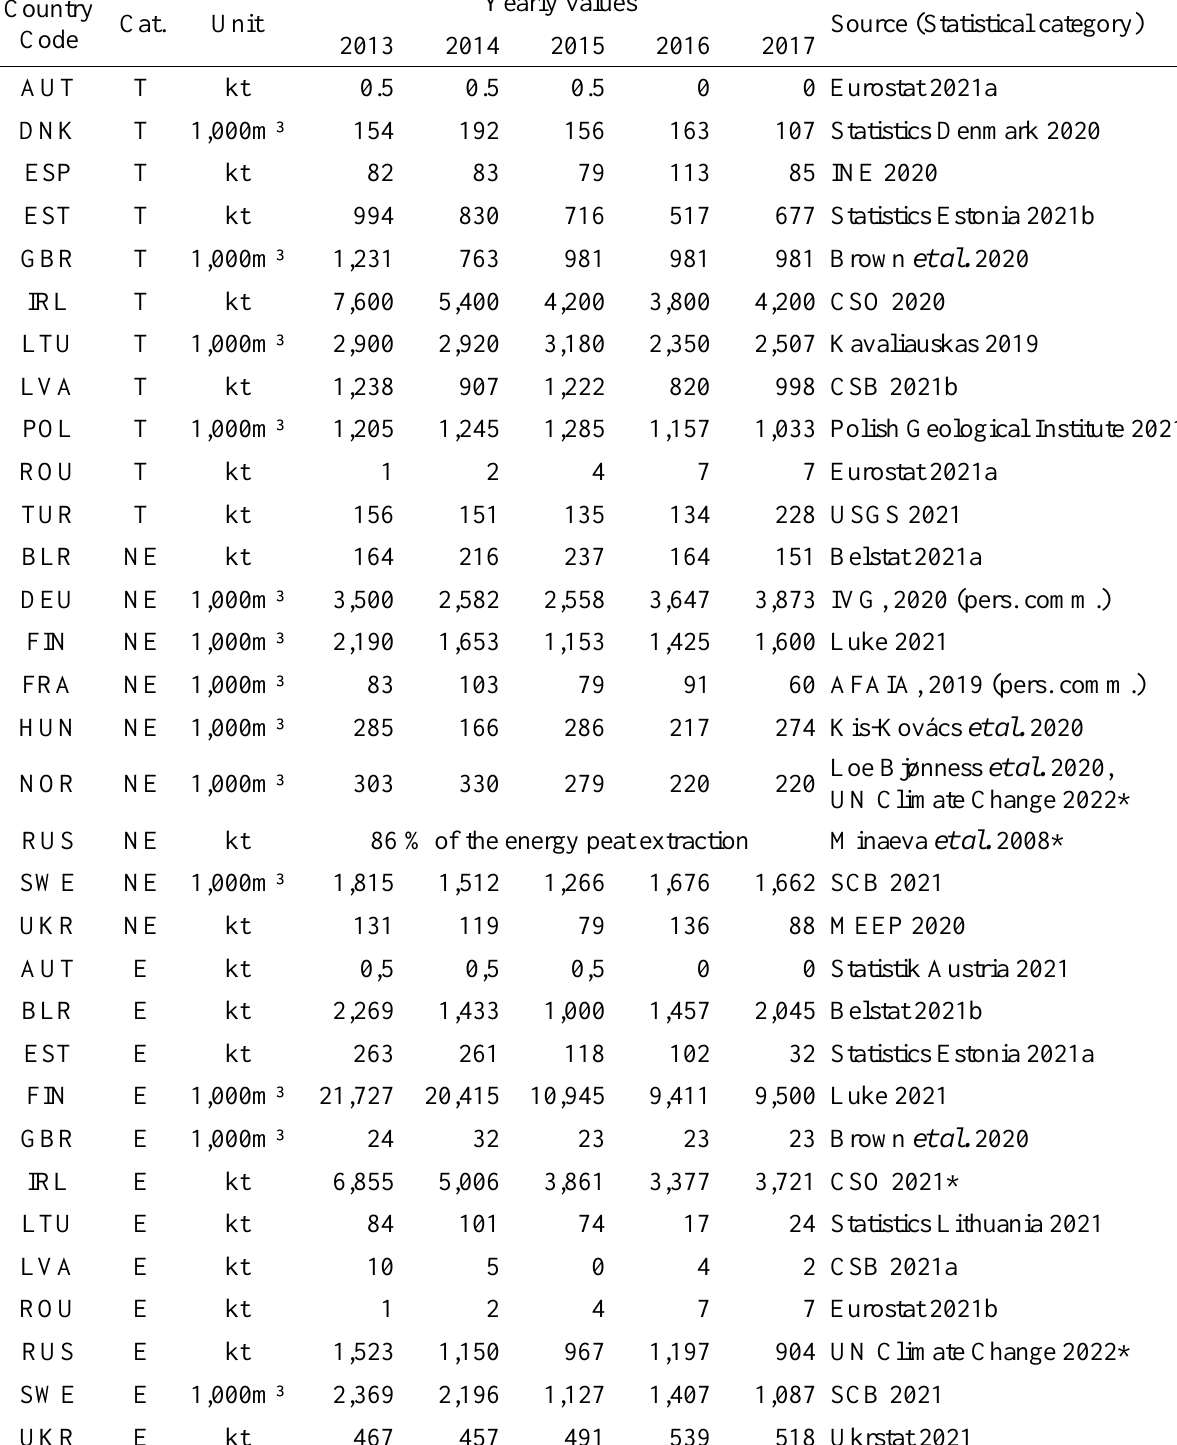
Table A1. Peat extraction data used as input. T = Total, E = Energy, NE = Non-energy, *calculation using